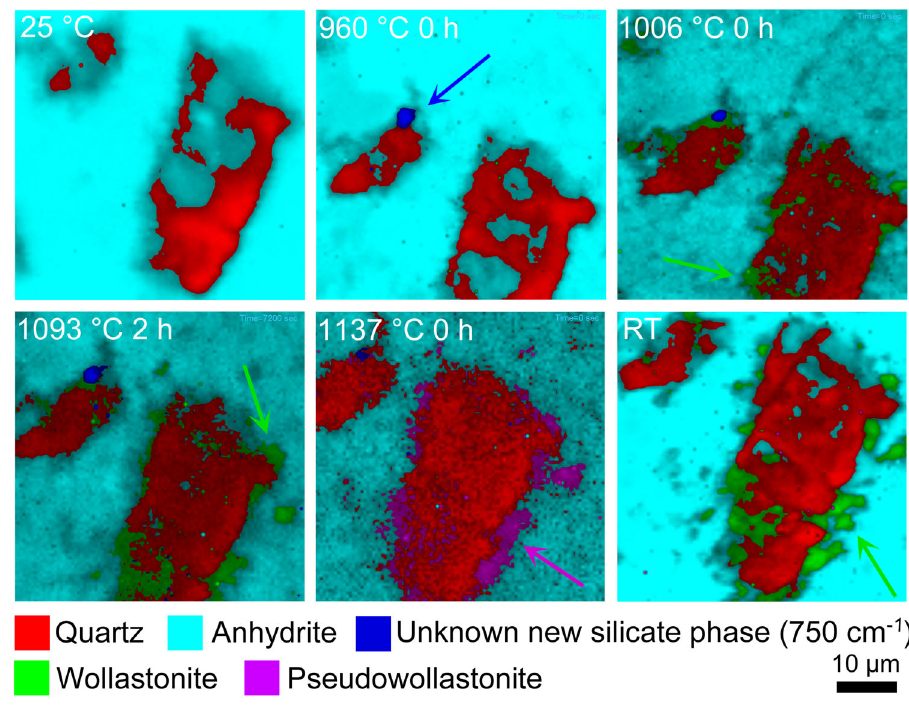
Fig. 7 Normalized false-color hyperspectral Raman images of the in situ experiment AQ-3.1